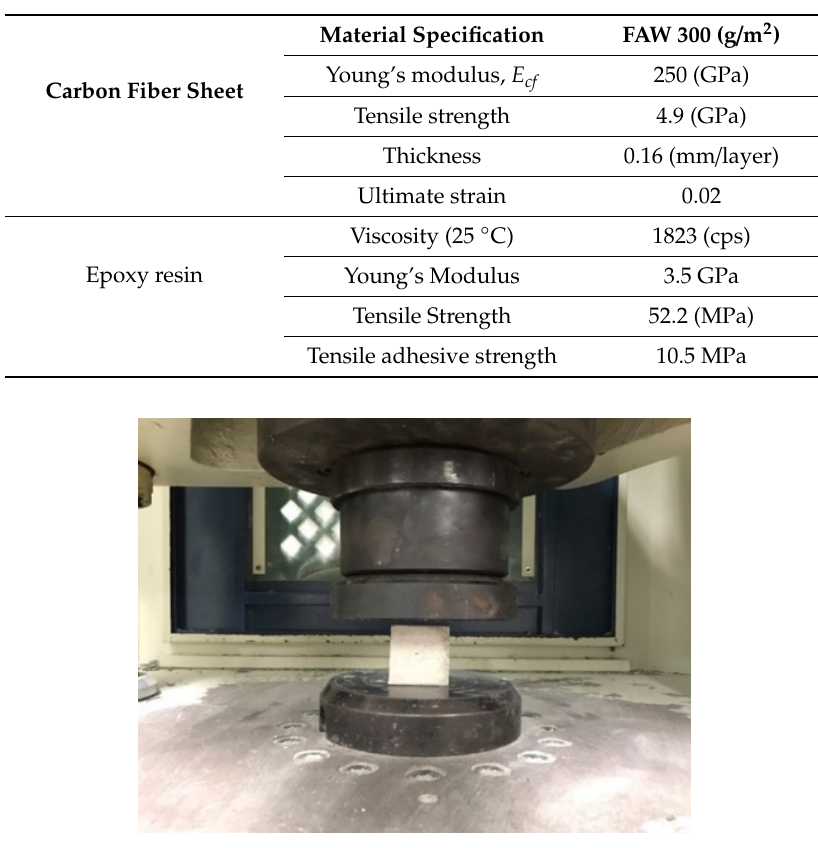
Table 2. Material properties of the carbon fiber sheet and epoxy resin.